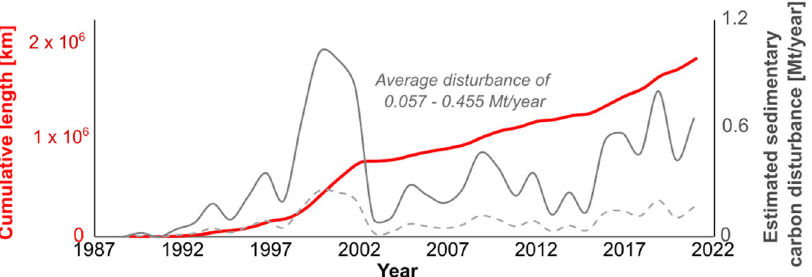
Fig. 5 | Cumulative length of fi ber-optic telecommunications cable installed (red) since start of records used in this study and the inferred rate of dis- turbance of sedimentary carbon (grey solid line is upper bound, grey dashed line is lower bound estimate). Note that this refers to the volumes of carbon